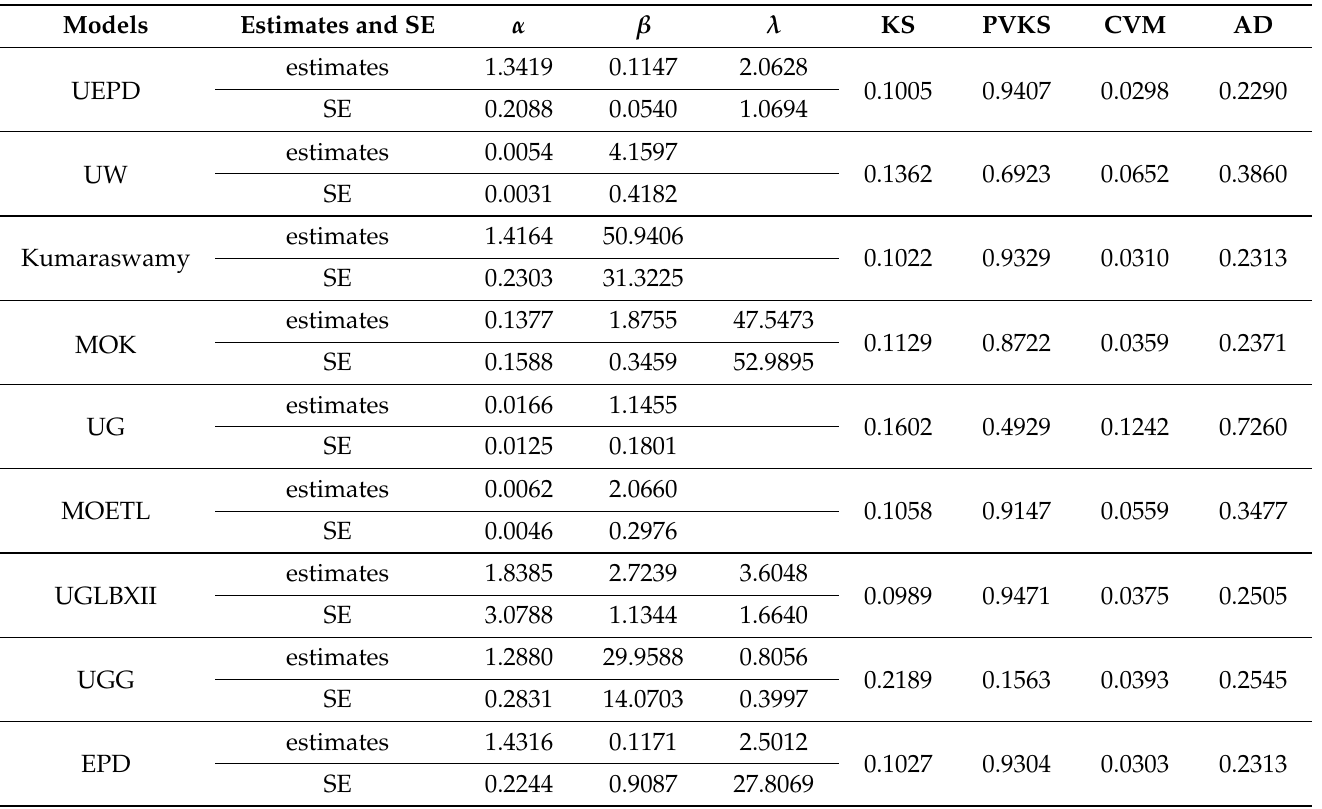
Table 5. M L E and SE with measures of goodness of fit for the recovery rate of COVID-19 data from